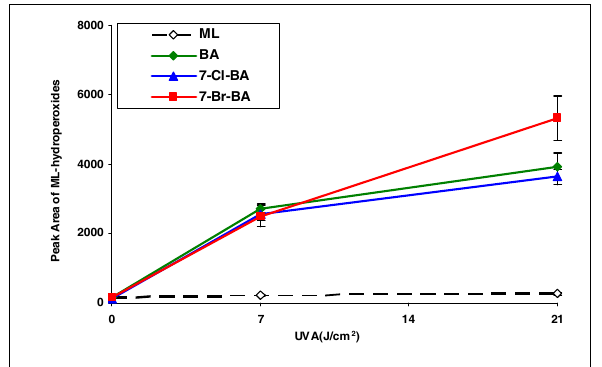
Figure 4: Peroxidation of methyl linoleate initiated by benzo[ a ]pyrene, 7-Cl-benzo[ a ]pyrene, 7-Br- benzo[ a ]pyrene, with, 0, 7, and 21 J/cm2 of UVA light.